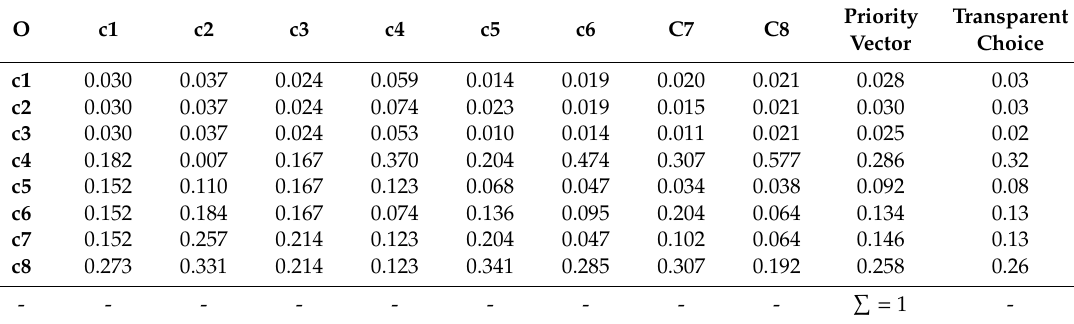
Table A7. Synthesised matrix for subcriteria associated with organisational barriers.